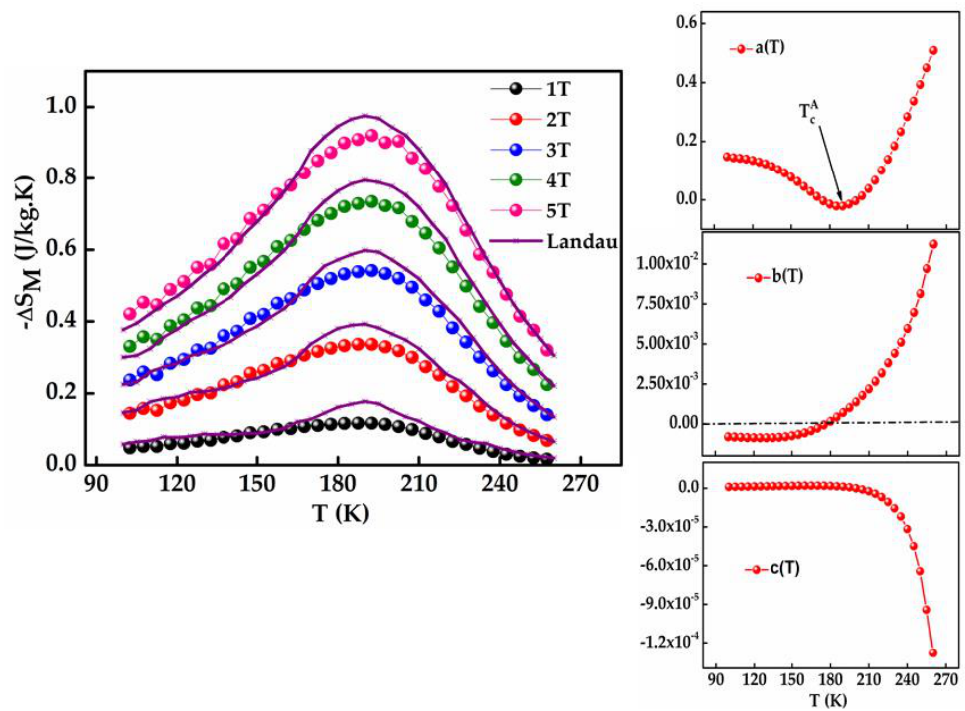
Figure 14. Superposition of experimental and calculated − ∆ S M ( T ) curves for Ni 51.82 Mn 32.37 In 15.81 ribbons under applied fields of 1 − 5 T ( left ), and the corresponding Landau coefficient a(T), b(T) and c(T) ( right ).